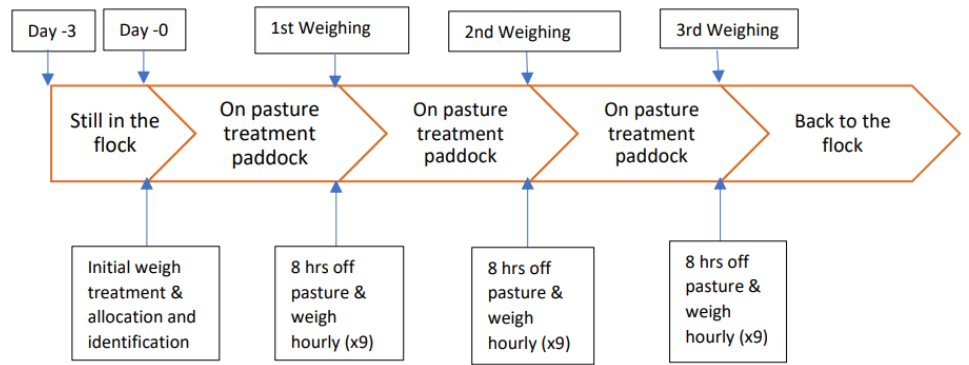
Figure 1. A timeline of the calibration study.